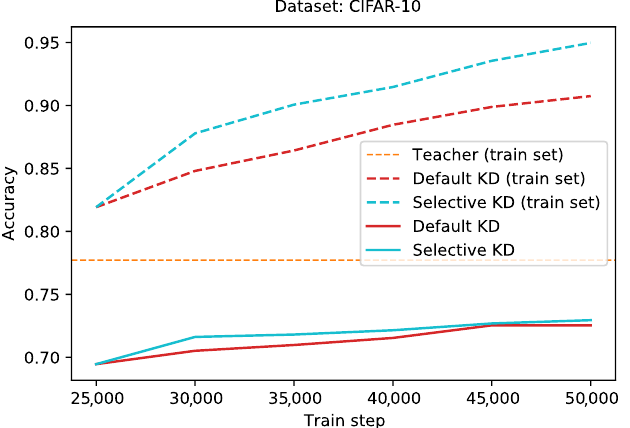
Figure 8. Intermediate performances of a student network trained using default knowledge distilla- tion, and a student trained using selective knowledge distillation, starting at the middle of training. Full lines represent test set accuracy, while the dotted lines stand for train set accuracy.